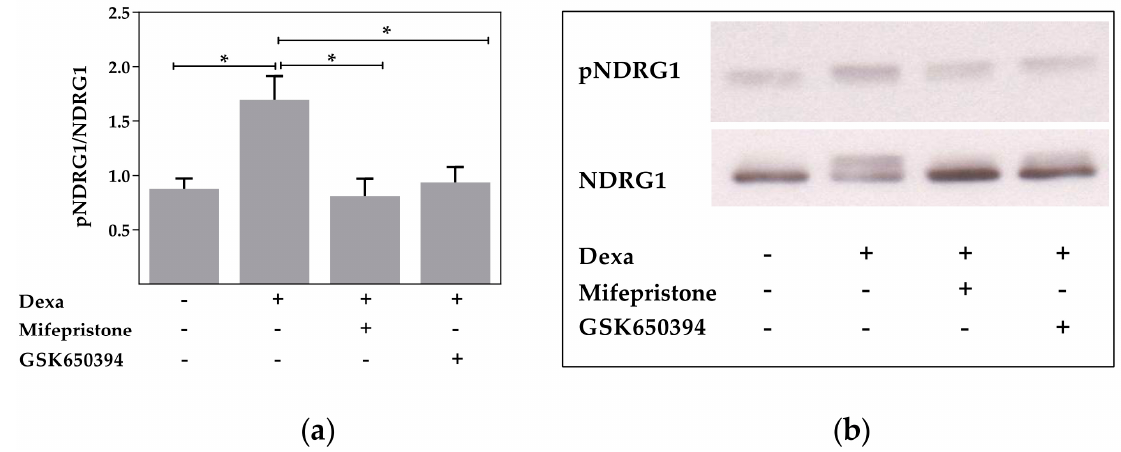
Figure 3. SGK1 activity is elevated by dexa and reduced by GSK650394. ( a ) Normalized densitometric evaluation of n-myc downregulated gene 1 (NDRG1) and pNDRG1 Western blots. Calu-3 cells were treated with 100 nM dexa and GSK650394 (10 µM) or mifepristone (10 µM) for 24 h ( n = 4; * p < 0.05 by t -test); ( b ) western blot of pNDRG1 and total NDRG1 resulted in bands of 46 and 48